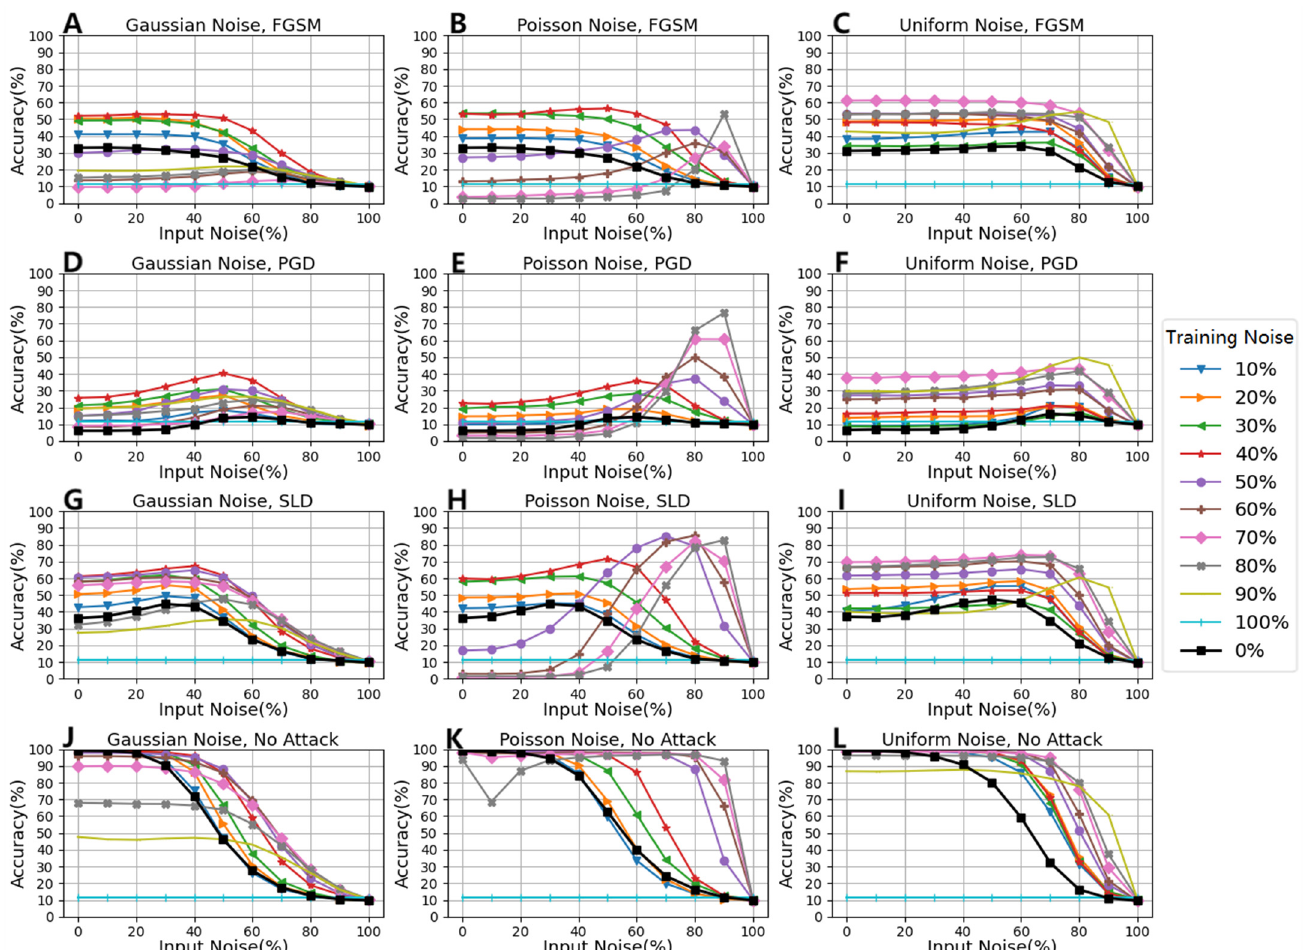
Figure 3. Accuracy of the MNIST at input noise dimension. The x axis is the input noise amplitude, and the y axis is the accuracy. Different color curves with various symbols indicate different amplitudes of training noise.